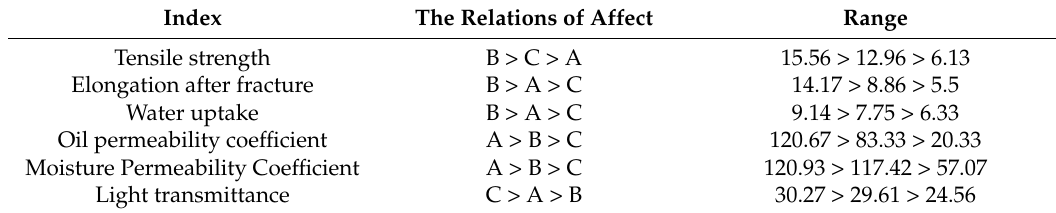
Table 6. The analysis of film